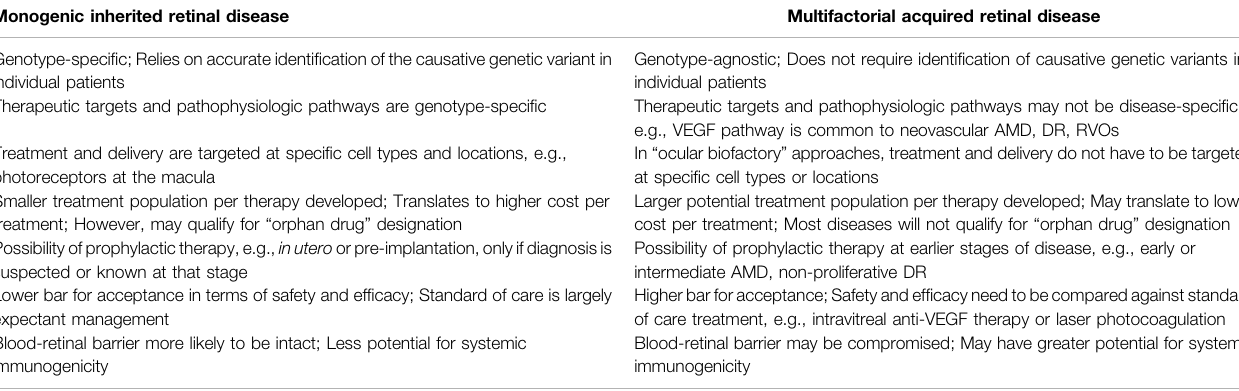
TABLE 1 | Key differences in the application of gene-based therapeutics for inherited and acquired retinal diseases. Monogenic inherited retinal